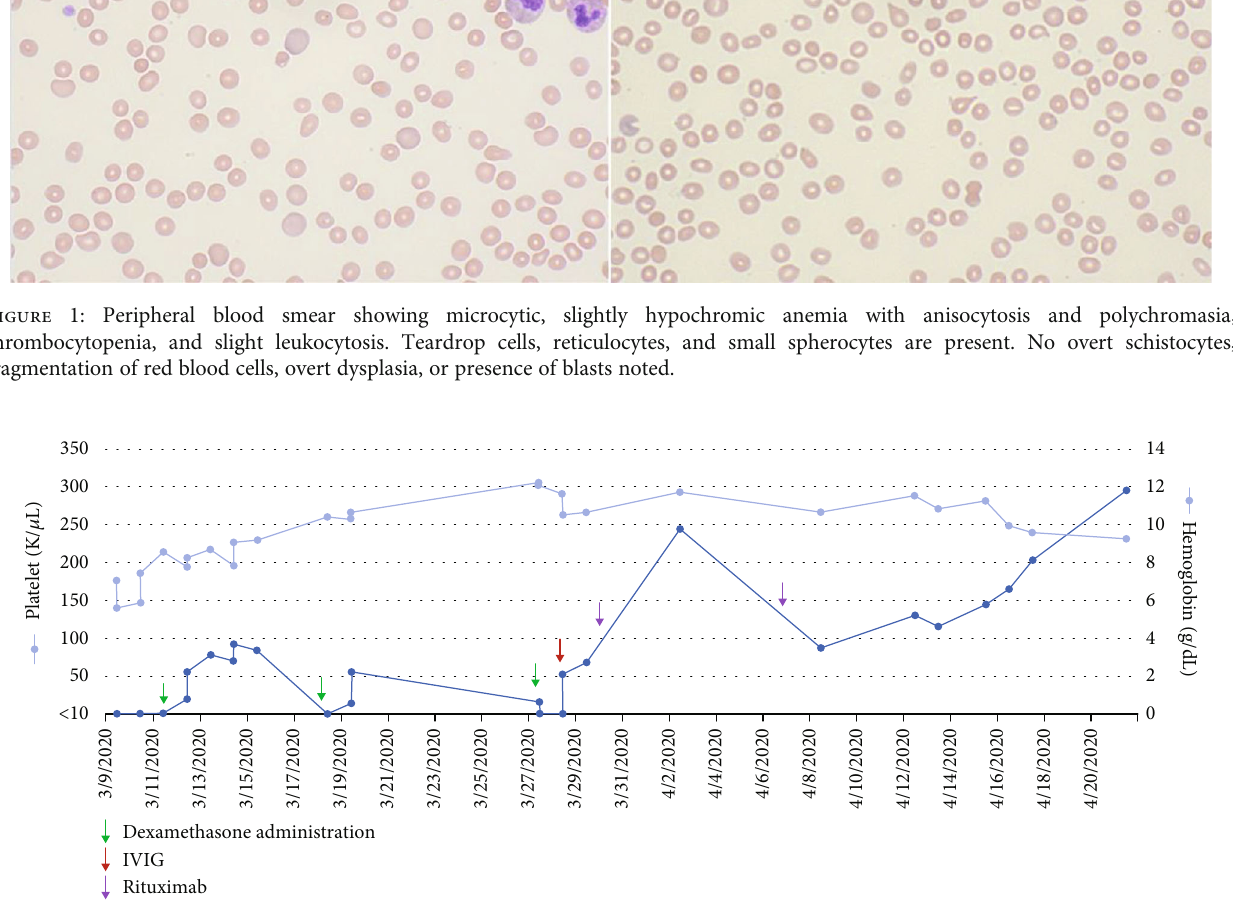
Figure 2: Platelet and hemoglobin values over time. Times of therapy noted by colored arrows. Initial course of steroids with good response, however subsequent decline in platelet count, requiring further treatment with additional steroids, IVIG, and rituximab. Abbreviations: IVIG: intravenous